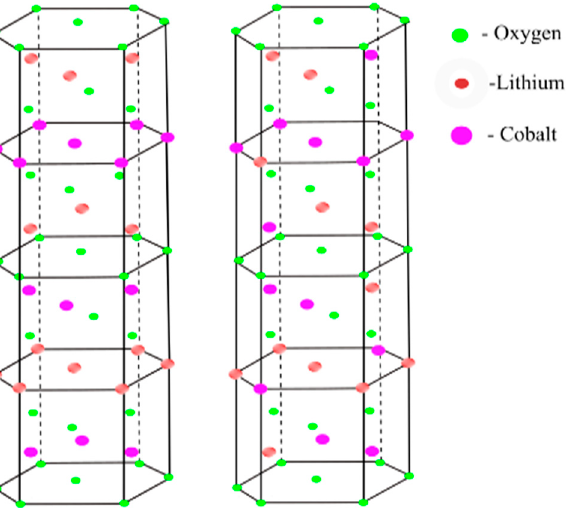
Figure 1. Rhombohedral structure (space group R - 3m) on the left and cubic structure (space group Fd3m) on the right.